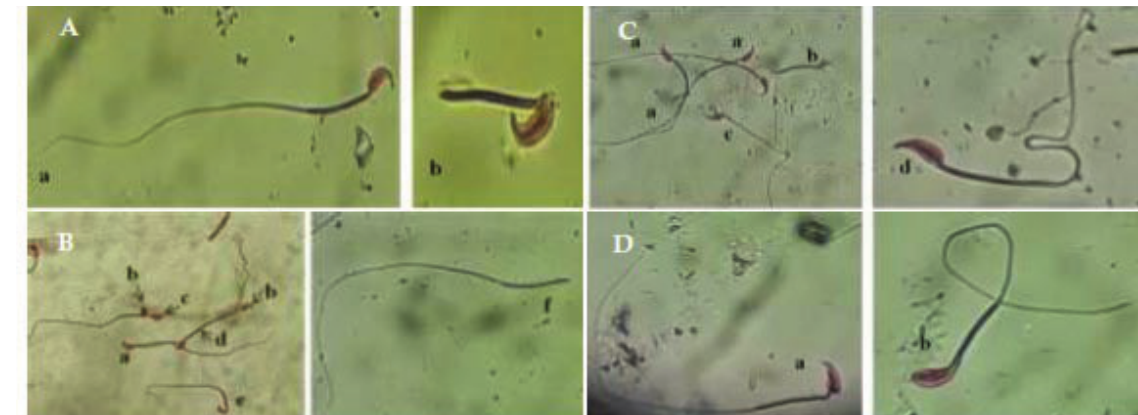
Figure 1. Normal and abnormal sperm Morphology in each group; A. NC-G; B. PC-G; C52-G; D. C78-G. There was no significant difference in number of normal sperm morphology amongst groups